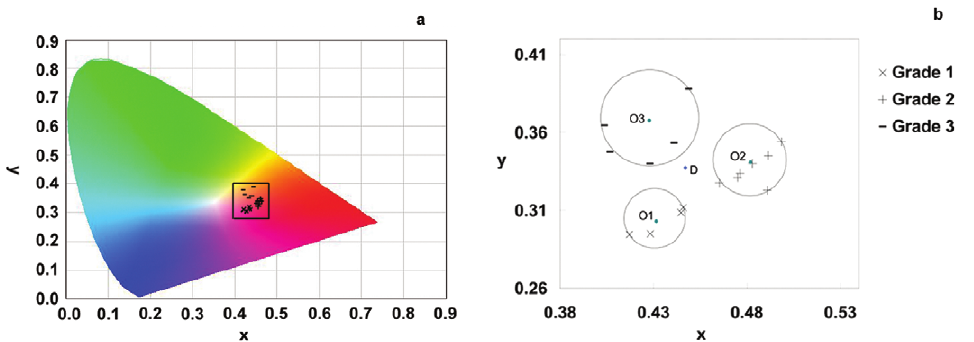
Figure 5. The distribution of the rhubarb samples in each grade in the CIE1931xy chromaticity diagram. a, The overall distribution of the samples in the two-dimensional coordinates overlaying on the CIE1931xy chromaticity diagram. The samples in the grade 1 mainly distribute in the lower left region favoring red-purple; the samples in the grade 2 distribute in the right region toward orange; and the samples in the grade 3 distribute in the upper left region tending toward yellow. b, Schematic diagram describing the geometric calculations for the segmentation points. The diagram represented the magnified region in the panel a.